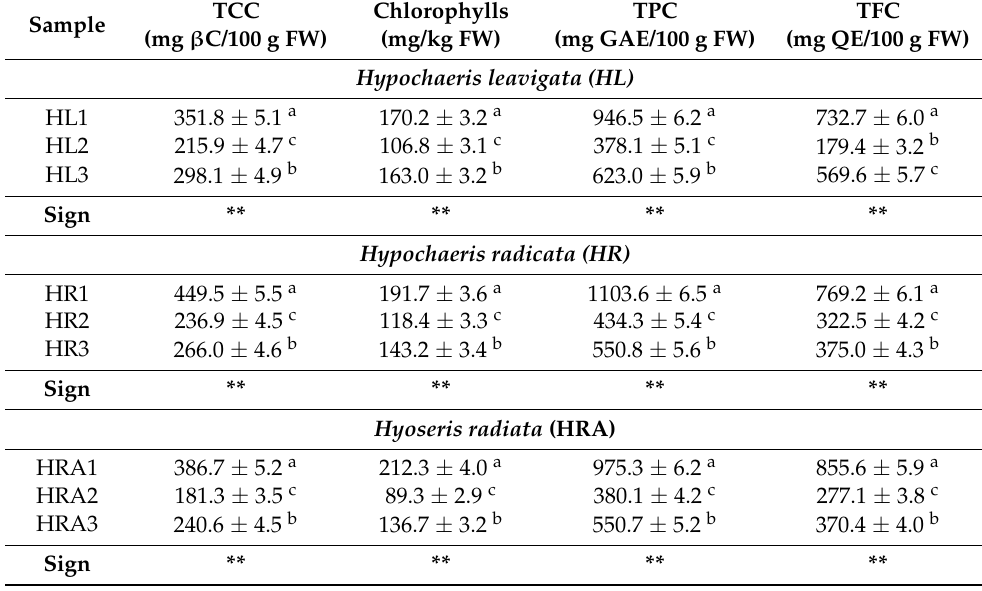
Table 3. Phytochemical content of Hypochaeris and Hyoseris extracts.